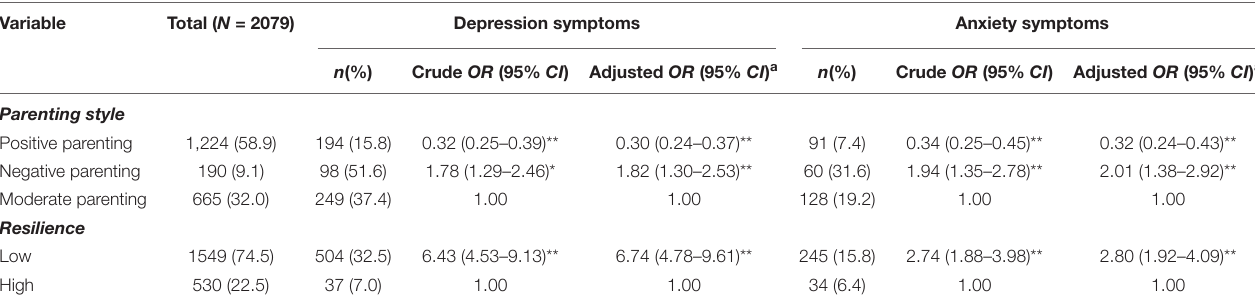
FIGURE 1 | Plot of 3 latent profiles of parenting styles. P1 = paternal emotional warmth; M1 = maternal emotional warmth; P2 = paternal severe punishment; M2 = maternal severe punishment; P3 = paternal excessive interference; M3 = maternal excessive interference; P4 = paternal rejection and denial; M4 = maternal rejection and denial; P5 = paternal over protection. TABLE 3 | Association of parenting style and resilience with depression/anxiety symptoms in